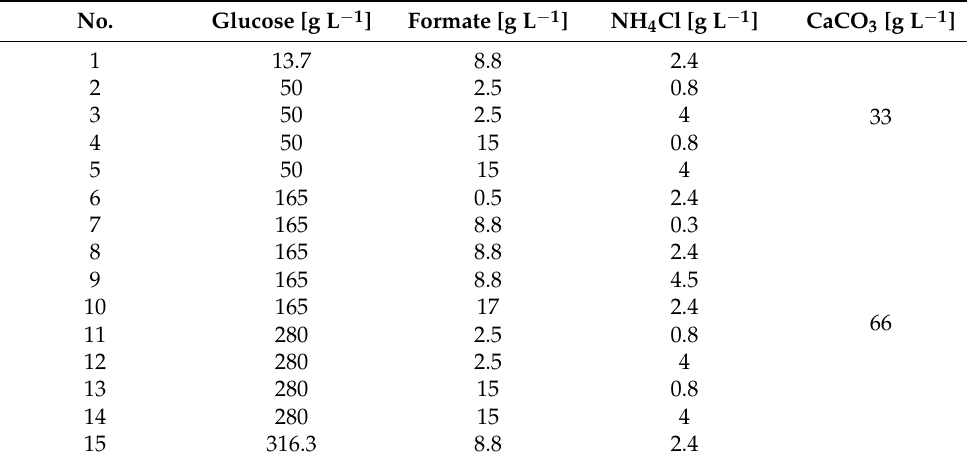
Figure 2. Visualization of the DoE design points. Conditions with the same formate concentration are colored the same way (low concentration colored in orange, medium concentration colored in green and high concentration colored in violet). Conditions of 165 + 8.8 + 2.4 mark the center point. Six points outside the cube are tested as well. Table 2. Tested DoE conditions during this study. Different combinations of glucose, formate and ammonium chloride in MTM using CaCO 3 buffer